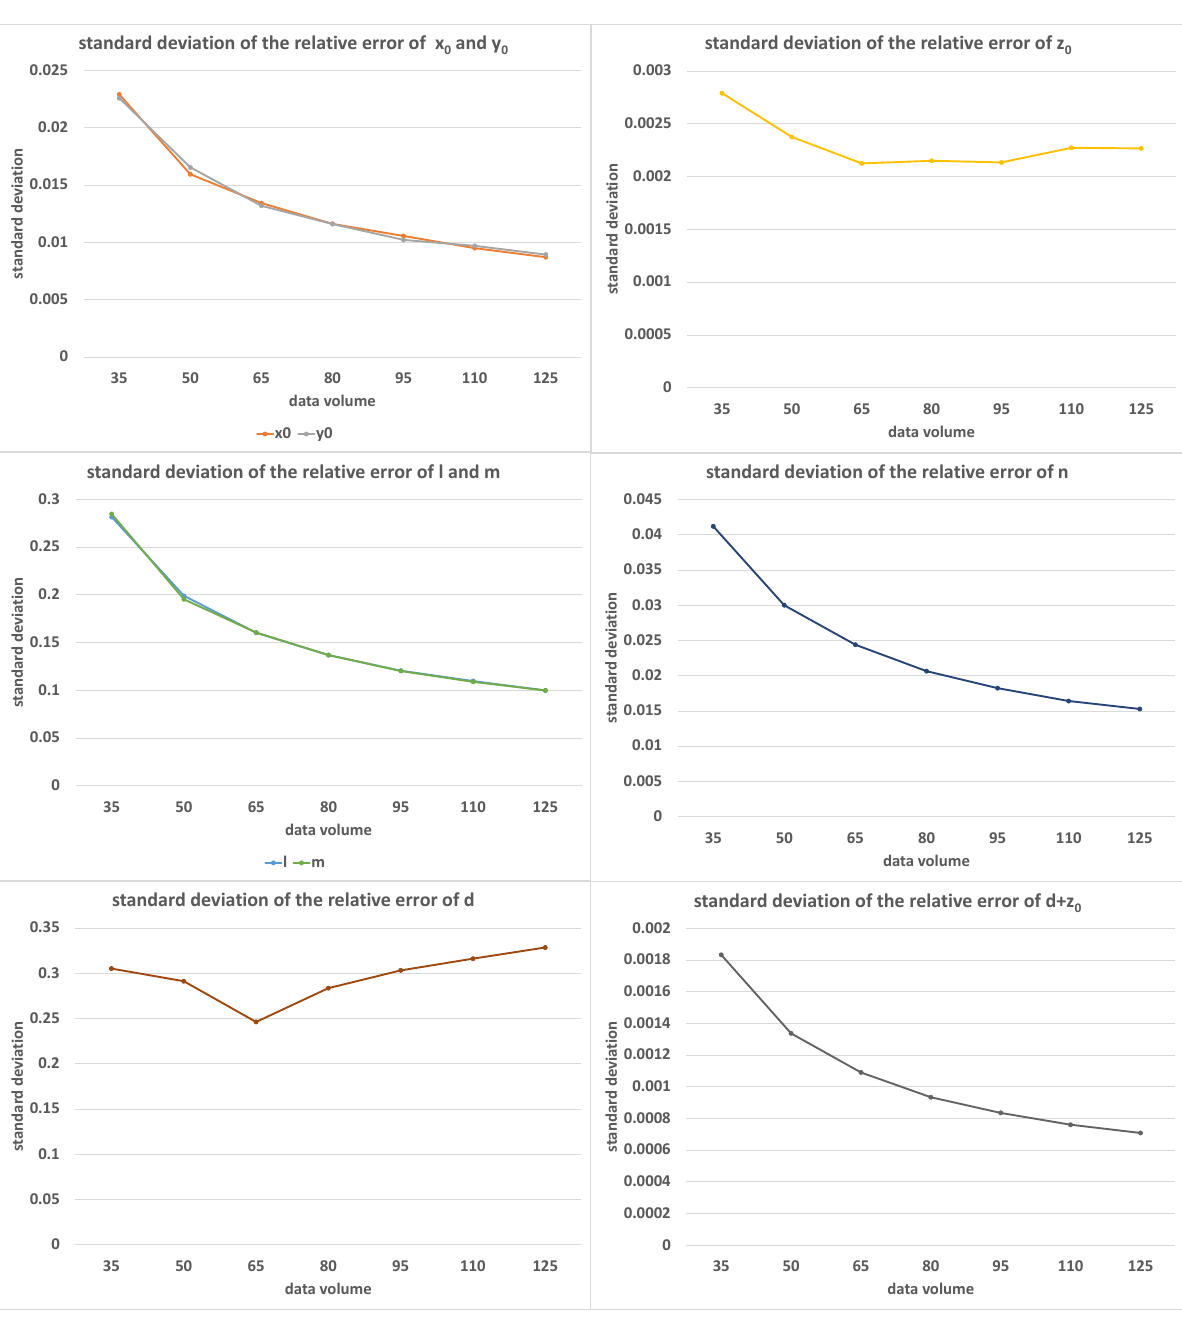
Figure 9. The standard deviations of relative errors of ( x 0 , y 0 , z 0 , l , m , n , d , d + z 0 ) with the increase in K ; the horizontal axis was measured in equation